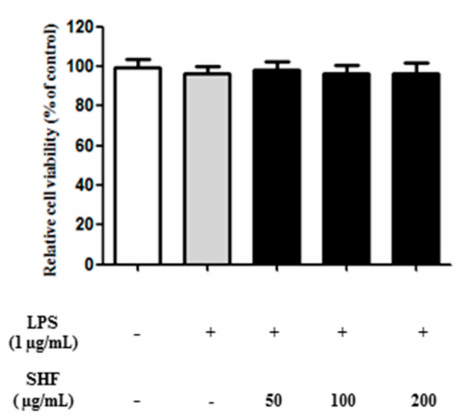
Figure 3. Effect of the Stauntonia hexaphylla fruit (SHF) extract on cell viability. RAW 264.7 cells were treated with 50–200 µ g/mL of the SHF extract and later treated with lipopolysaccharide (LPS) (1 µ g/mL) for 18 h. Cytotoxicity was estimated by the MTT